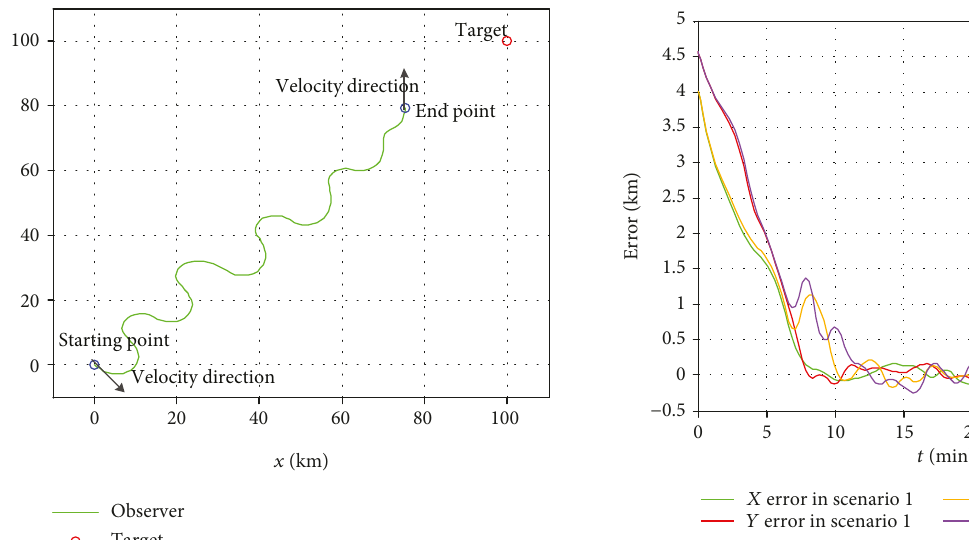
Figure 3: Target tracking results in scenario 1,